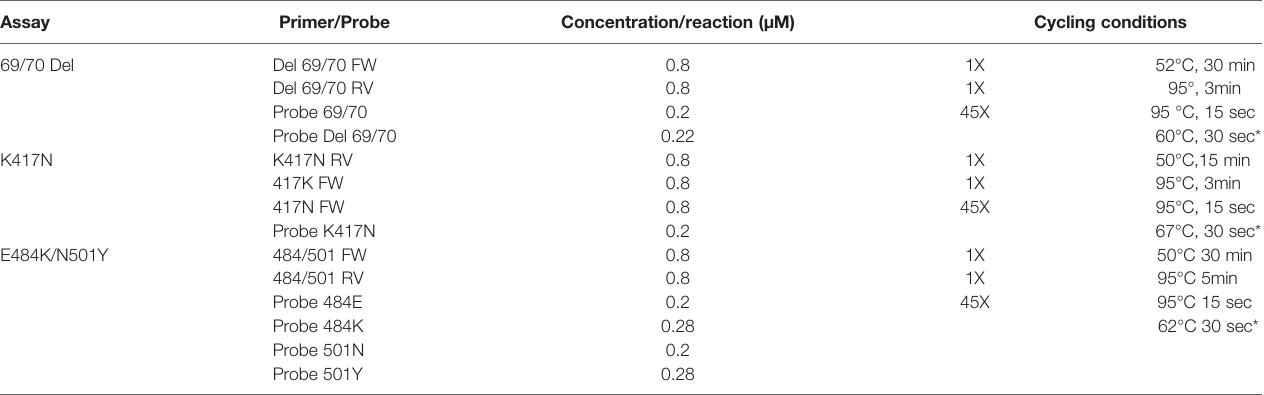
TABLE 3 | Reaction and ampli fi cation conditions of the